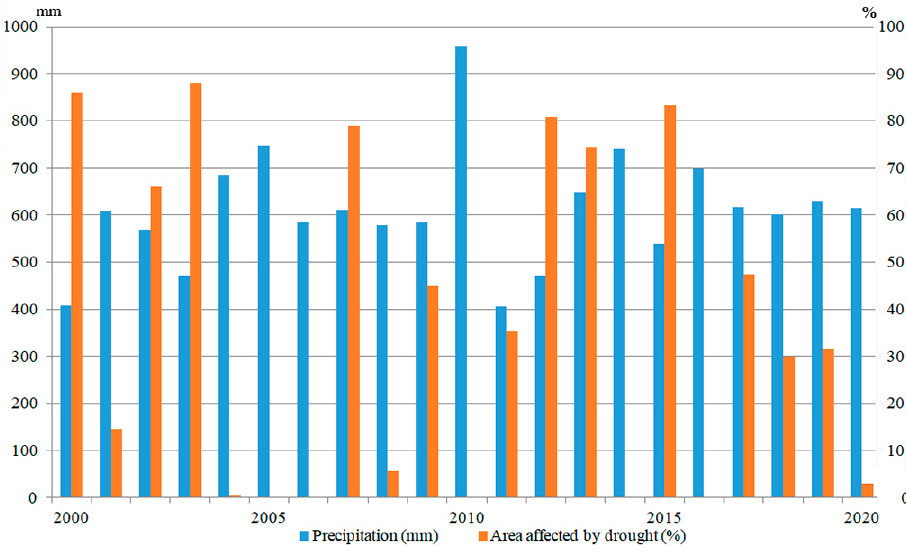
Figure 3. The relationship between the amount of annual precipitation and drought-affected areas in Hungary in the period 2000-2020 (based on the Hungarian Central Statistical